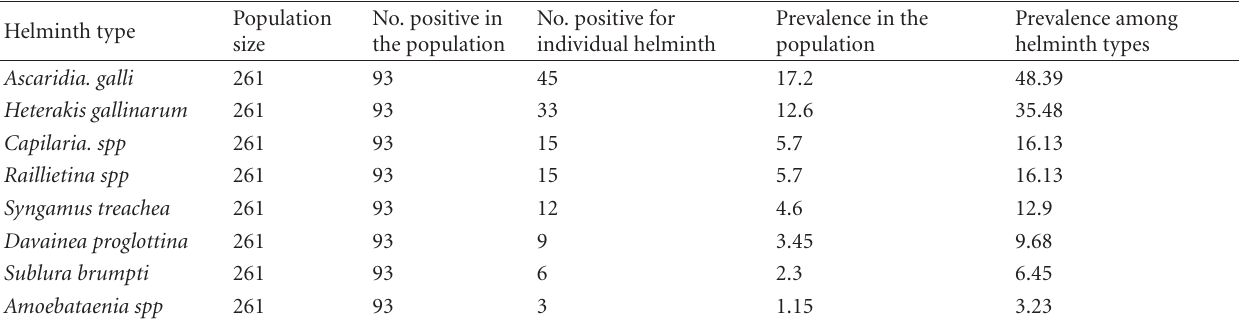
Table 3: The prevalence of the various helminth species in the sample population, n =